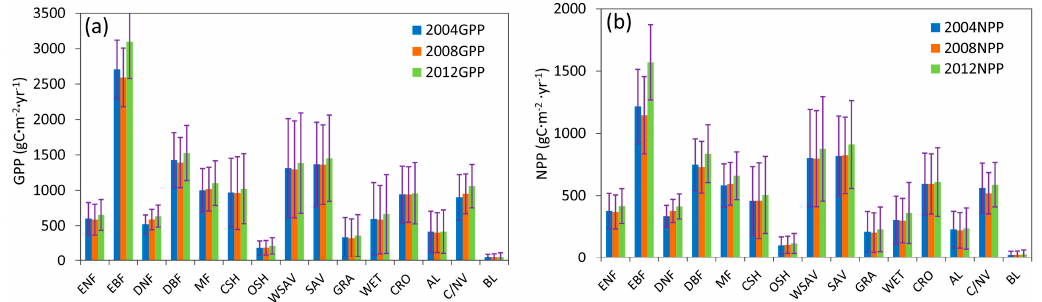
Figure 6. Global mean and standard deviations of GPP and NPP for all vegetated land cover types: ( a ) global mean and standard deviations of GPP; ( b ) global mean and standard deviations of NPP.